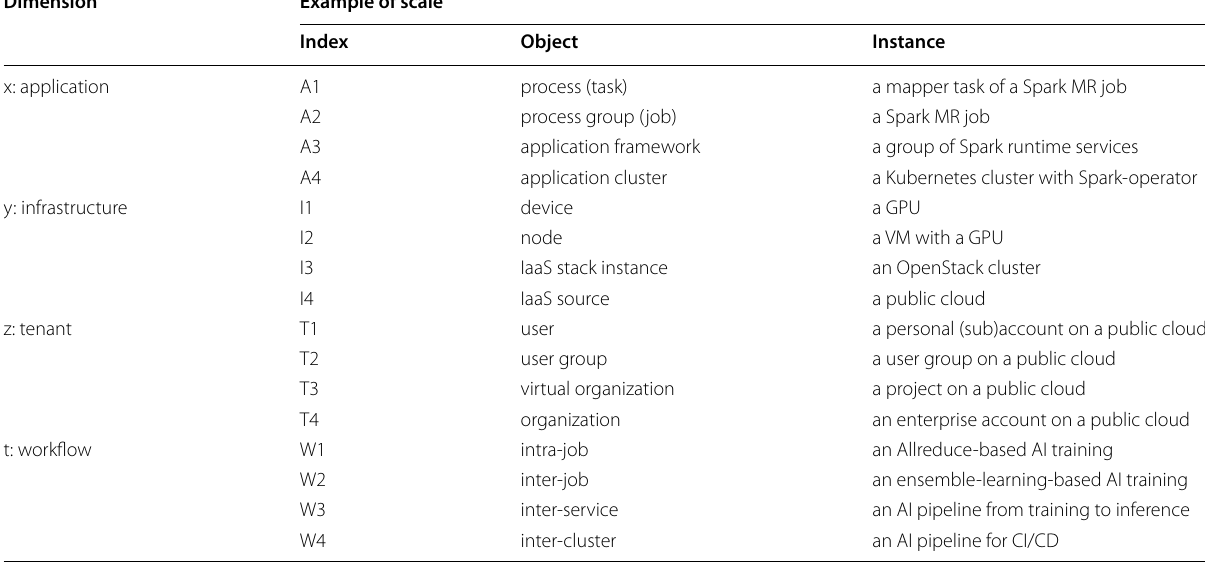
Table 1 The dimensions of the cloud-native light-cone model Dimension